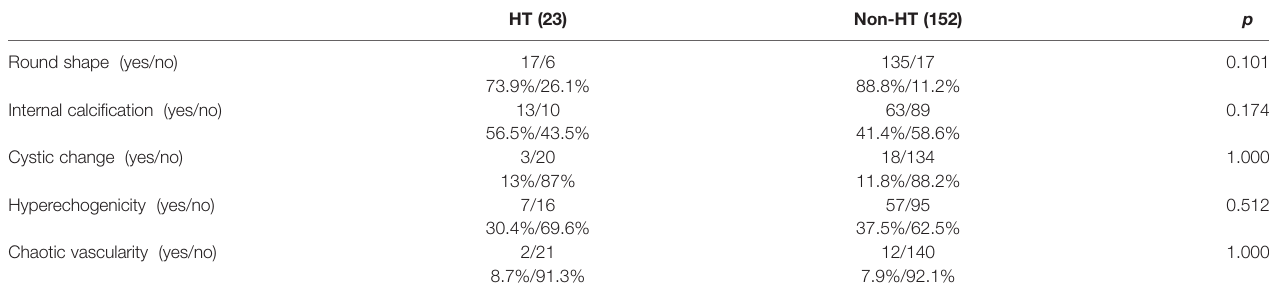
TABLE 2 | Sonographic characteristics of suspicious lymph node.